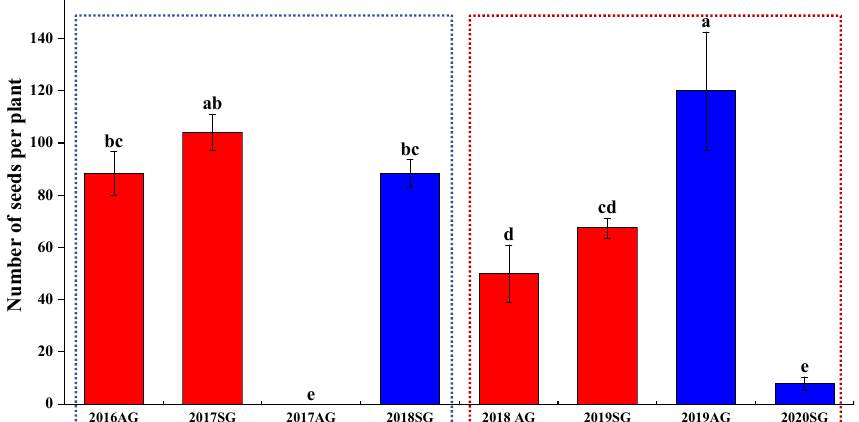
Figure 12. Number of offspring (F2) seeds per individual of spring (SG)- and autumn (AG)-germinating plants of Erodium oxyrhinchum in wet ( left ) and dry ( right ) springs. Different lowercase letters indicate significant differences ( p < 0.05) among SG and AG in dry and wet springs. Vertical bars indicate standard errors of the means (n = 8).